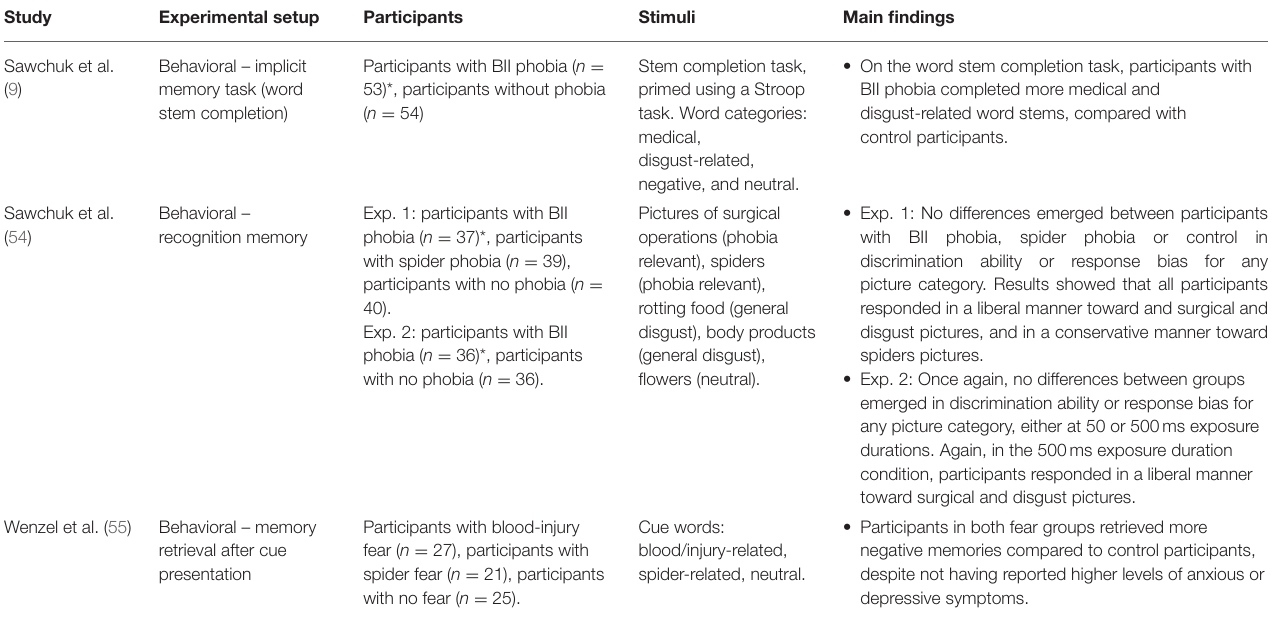
TABLE 3 | Summary of studies on memory bias in BII